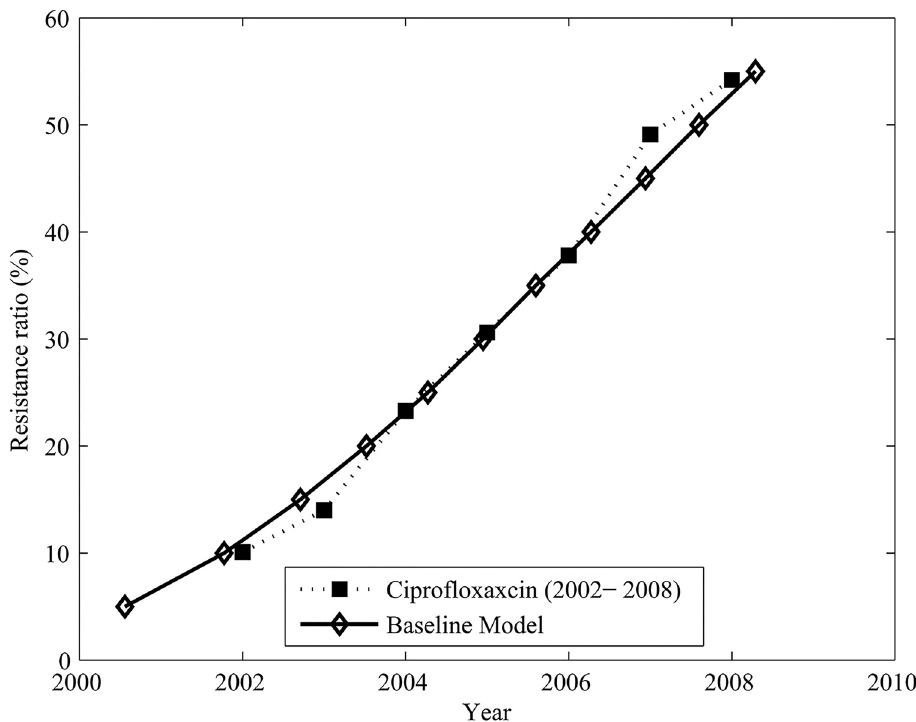
Fig 2. Resistance proportion obtained in the model through calibration to data on ciprofloxacin resistance in Australia. Resistance proportion obtained in the model (solid line with diamond markers) through calibration to data on ciprofloxacin resistance in Australia between 2002 and 2008 (dotted line with square markers, from [22]).